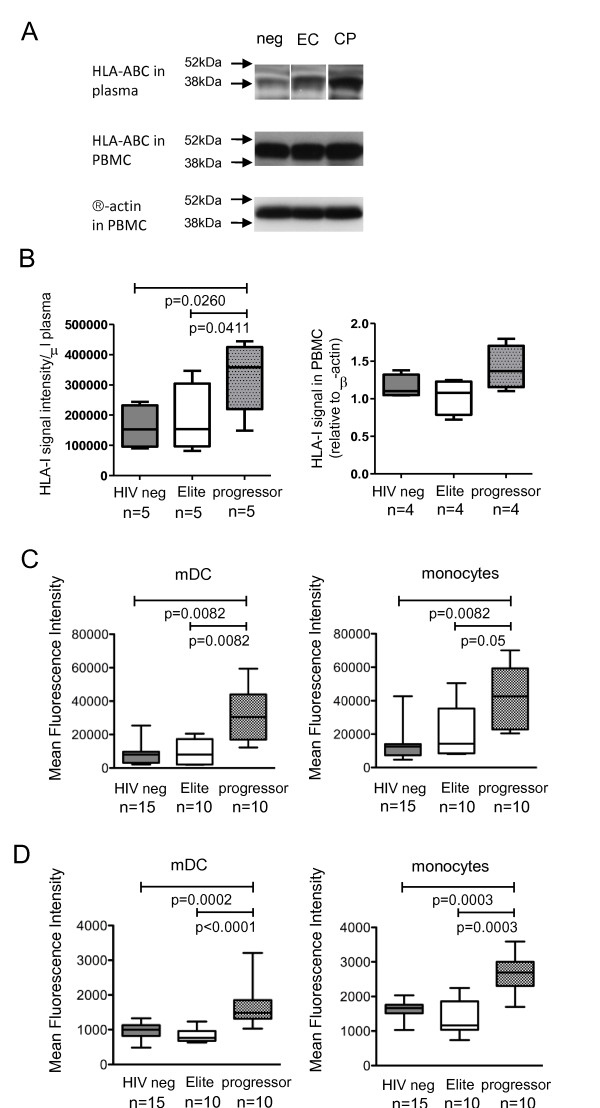
Increased expression of soluble HLA class I molecules in progressive HIV-1 infection. (A-B): Western blots reflecting HLA class I expression in the plasma and in PBMC of persons with progressive HIV-1 infection, elite controllers and HIV-1 negative individuals. (A) shows representative data from a given patient from each study cohort; (B) demonstrates cumulative data from indicated patient numbers. (C-D): Expression of intracellular (C) and membrane-bound (D) HLA class I molecules in monocytes and dendritic cells from the three study cohorts.